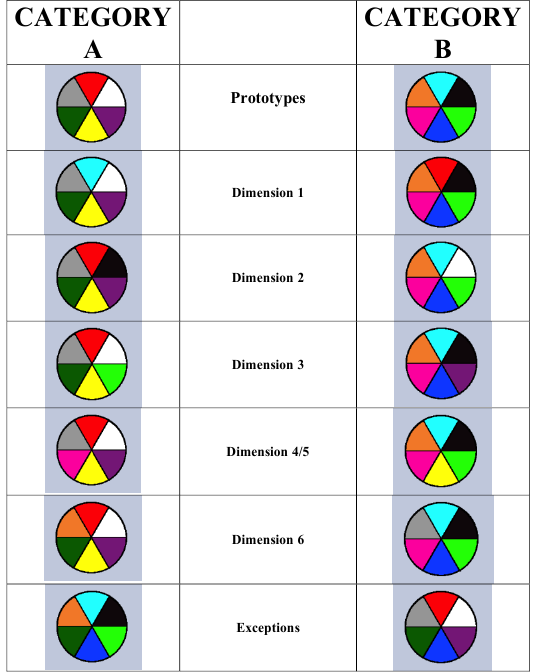
Figure 6. Illustrating the prototype-exception task used to test pigeons and humans in Cook and Smith [44]. Each category contained a prototype (Row 1), five typical stimuli (Rows 2–6—five features shared with their prototype), and an exception (Row 7—five features shared with the opposing prototype). From [44]. Copyright 2006 by the Association for Psychological Science. Reprinted with permission.